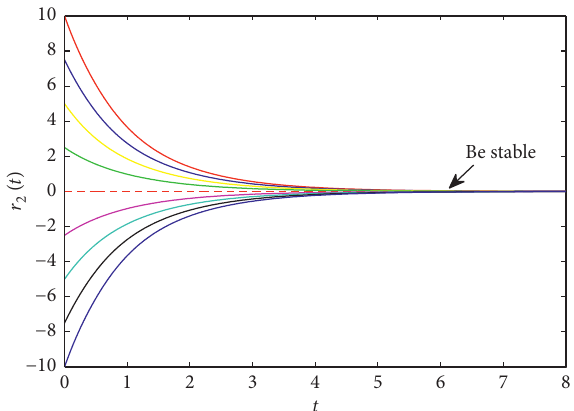
Figure 1: Stable behavior of y